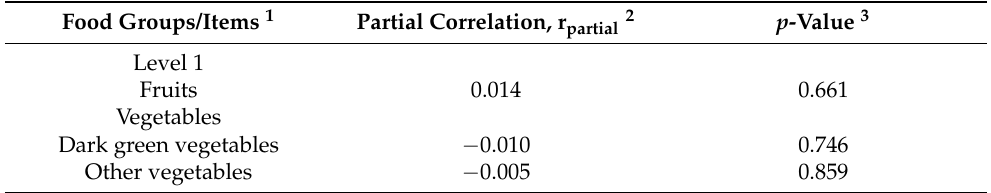
Table 5. Partial correlation between ∆ dietary intake patterns and weight loss during the COVID-19